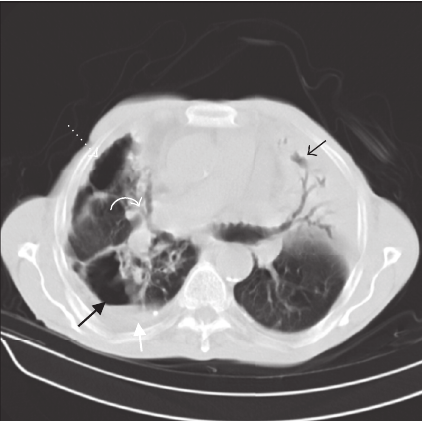
Figure 2: 75-year-old male. Spiral CT scan at the level of pulmonary artery (lung window). Note consolidation with air bronchogram in lingula (black arrow) and air-fluid containing cavity in right lower lobe (thick black arrow) adjacent to pleural effusion (thick white arrow). There are also bronchiectasis in right middle lobe (curved arrow) and pneumothorax (dotted arrow).